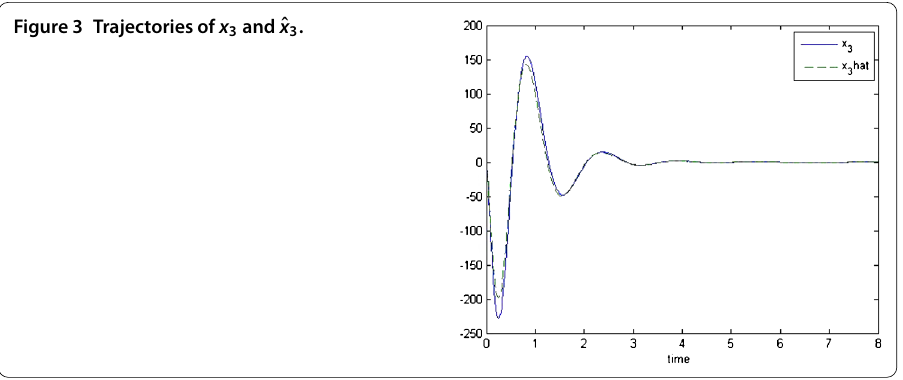
Figure 3 Trajectories of x 3 and ˆ x 3